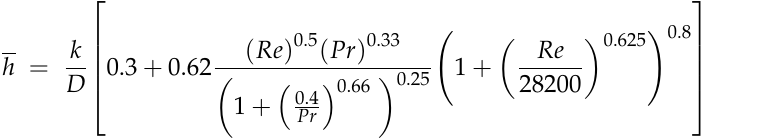
by the empirical correlation of Churchill and Bernstein [16] (valid for 100 < Re < 10 7 and Re · Pr >